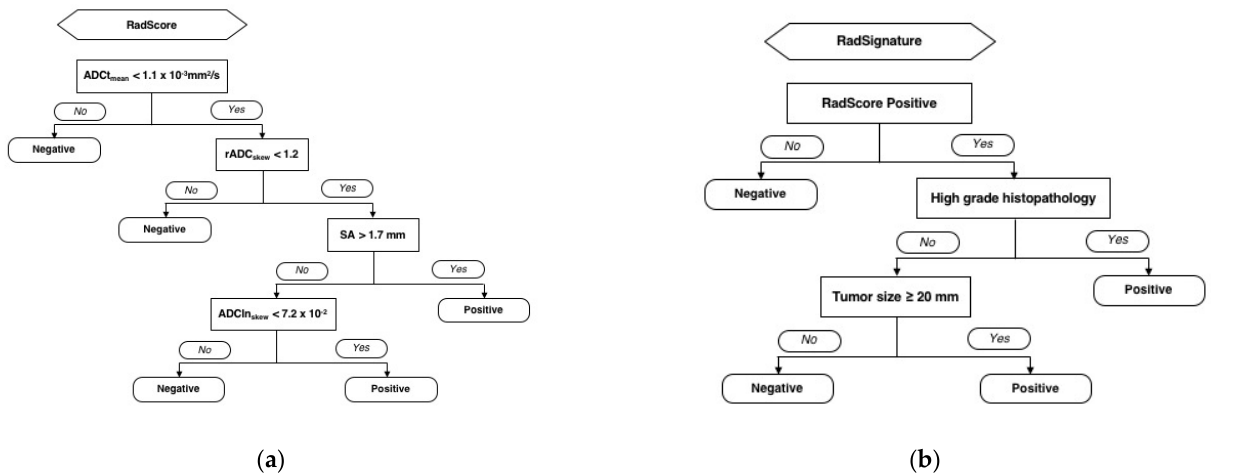
Figure 3. The development of RadSignature to predict lymph node metastasis in endometrial cancer patients. The RadScore was developed based on image only radiomics classification and regression tree analysis ( a ) The RadSignature was determined by combination of RadScore and clinical parameters ( b ) The rpart package in R was used, and 10-fold cross-validation process repeated 10 times to select the best fitting.